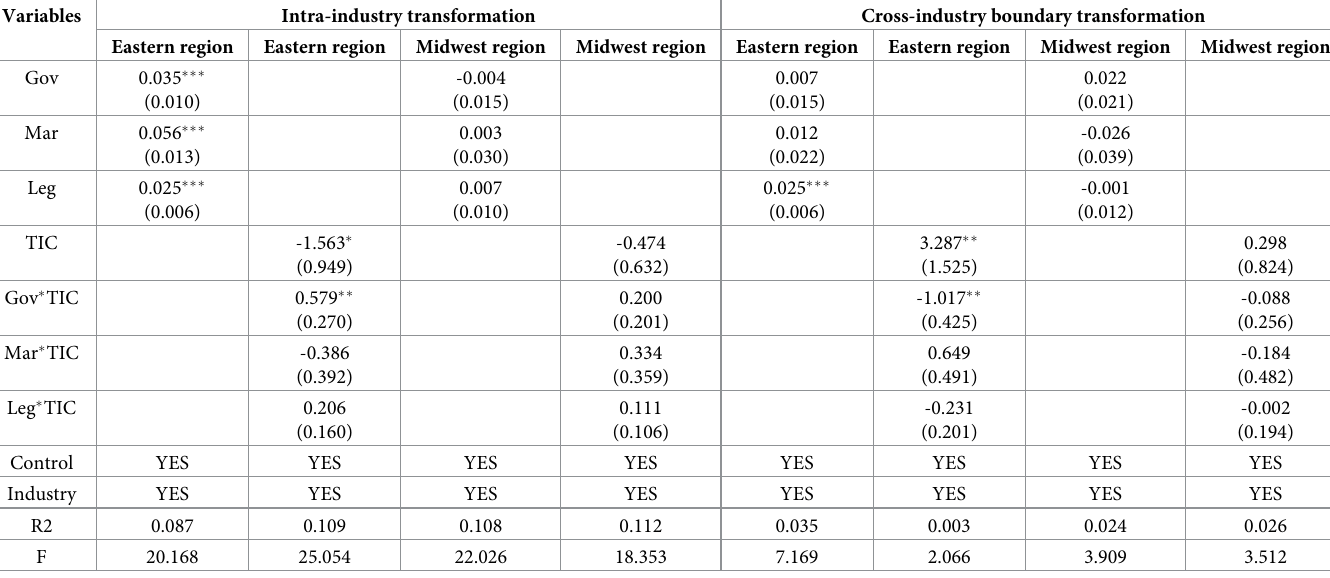
Table 8. Regression analysis of institutional environment, technological innovation ability and degree of transformation in different